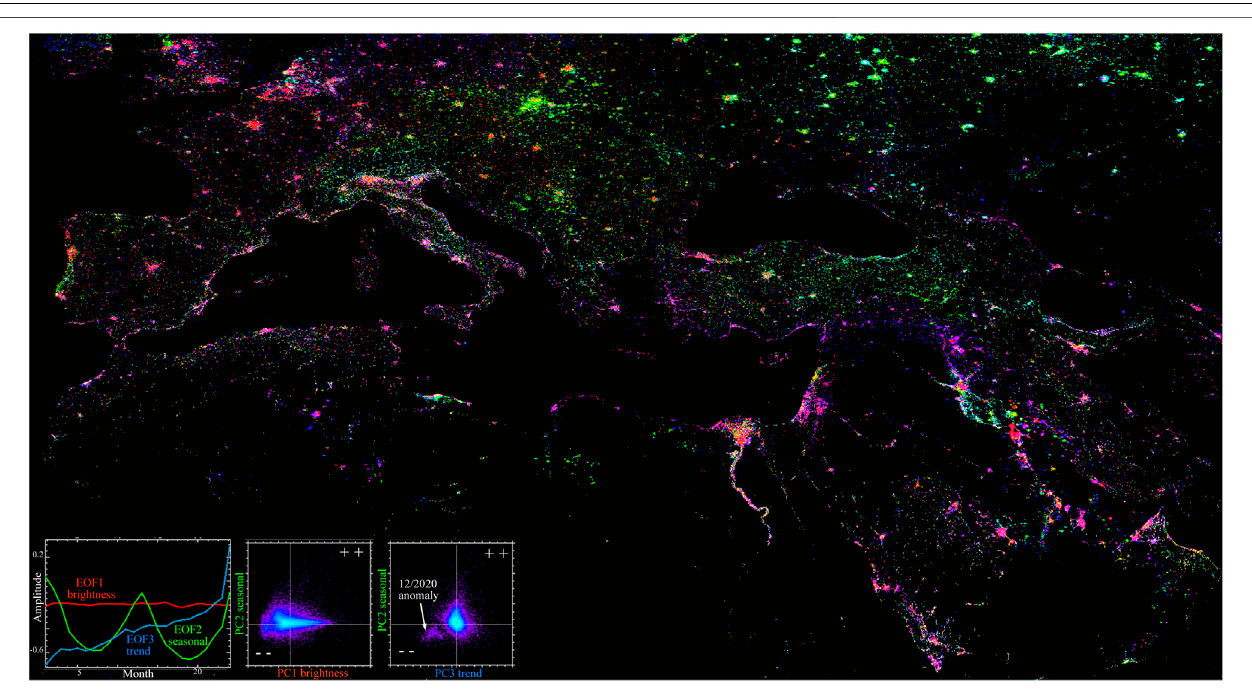
FIGURE 5 | PCs,EOFsandtemporalfeaturespacefor2019+2020monthlytimeseriesforEurasiawithluminancethresholdapplied.PC1,PC2andPC3accountfor 88, 2 and 2% of spatiotemporal variance (respectively). The > 10 +0.5 nW/cm 2 /sr low luminance threshold eliminates large areas of background luminance so the transformation re fl ects the spatiotemporal characteristics of the much smaller area of brighter anthropogenic luminance. Bright, temporally stable, urban cores appear red because brightness is modulated by EOF1 and PC1. Magenta and green areas represent variations in the lower luminance periphery where seasonal and interannual changes from residual background luminance approach the contribution of the dimmer anthropogenic light sources. Most of the seasonal (green) areas correspond to mountains or steppe where winter snow and summer vegetation result in higher winter and lower summer albedo. The sign of each PC value determines the polarity of its EOF.ThedistinctclusterofpixelsinquadrantthreeofPC2-PC3correspondstopartsofeasternEuropeandRussiawhereDecember2020hadanomalouslylowluminance.